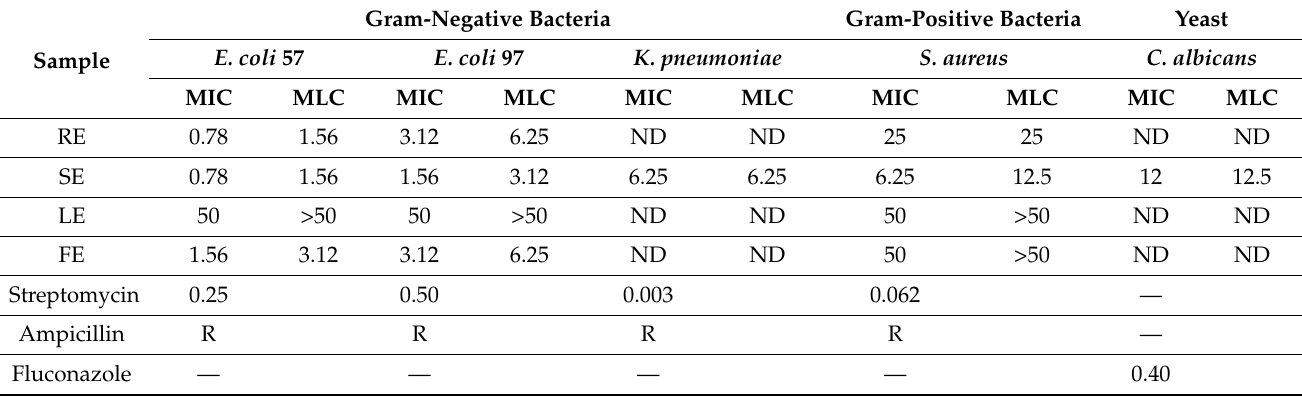
Table 4. Minimal inhibitory concentration (MIC) and minimum lethal concentration (MLC) of P. rhoeas extracts